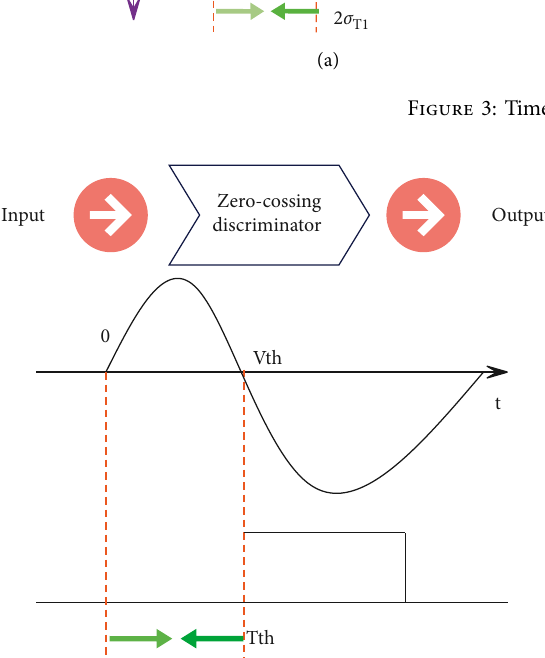
Figure 3: Time wobbles caused by